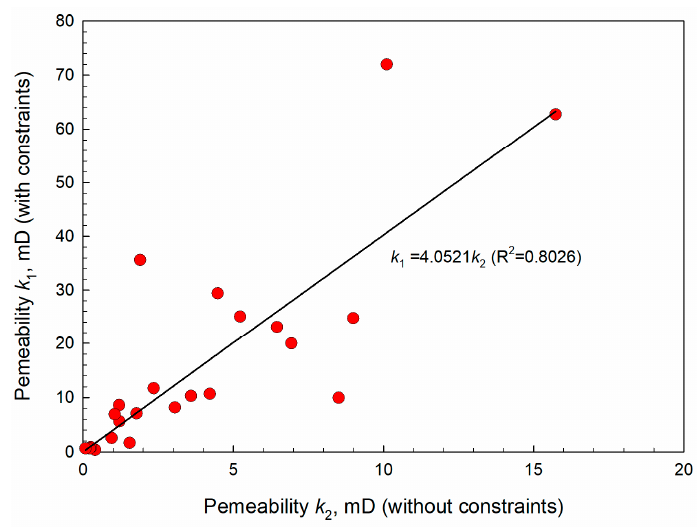
Figure 6. Effect of the skin factor constraint on the formation permeability near the wellbore interpreted from well-testing results.